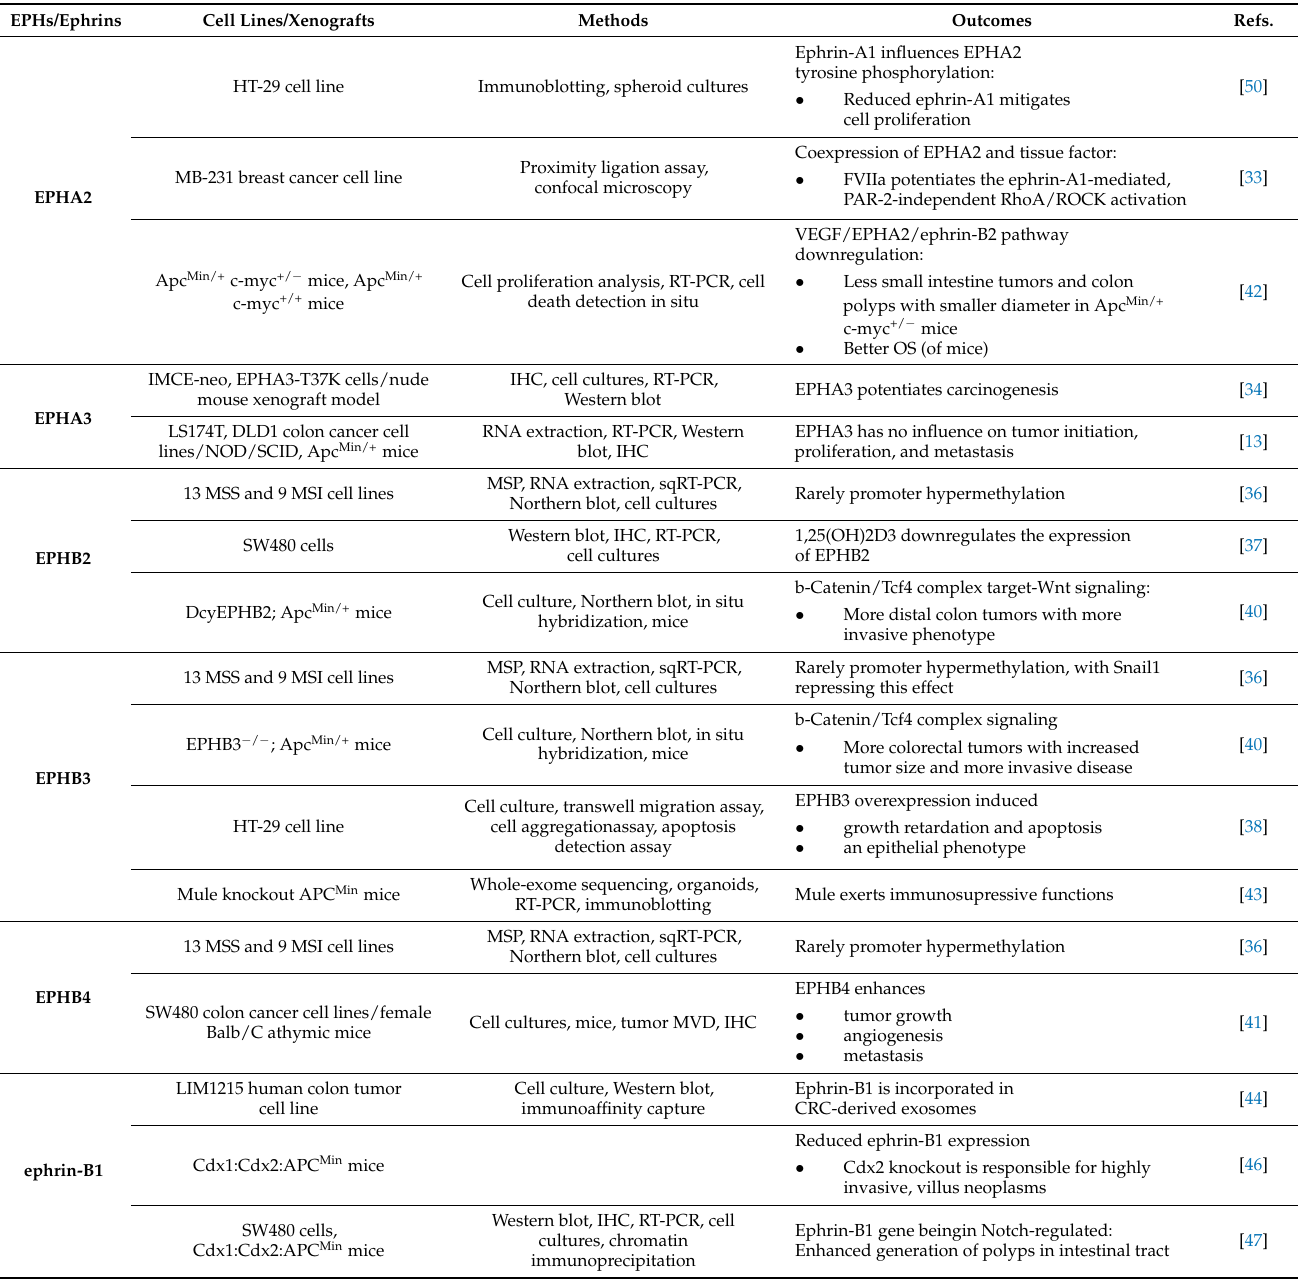
Table 1. EPHs/ephrins studied in cell lines and xenografts, methods utilized, and results